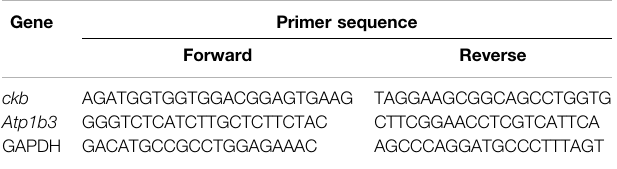
TABLE 1 | Primers used for the quantitative RT-PCR